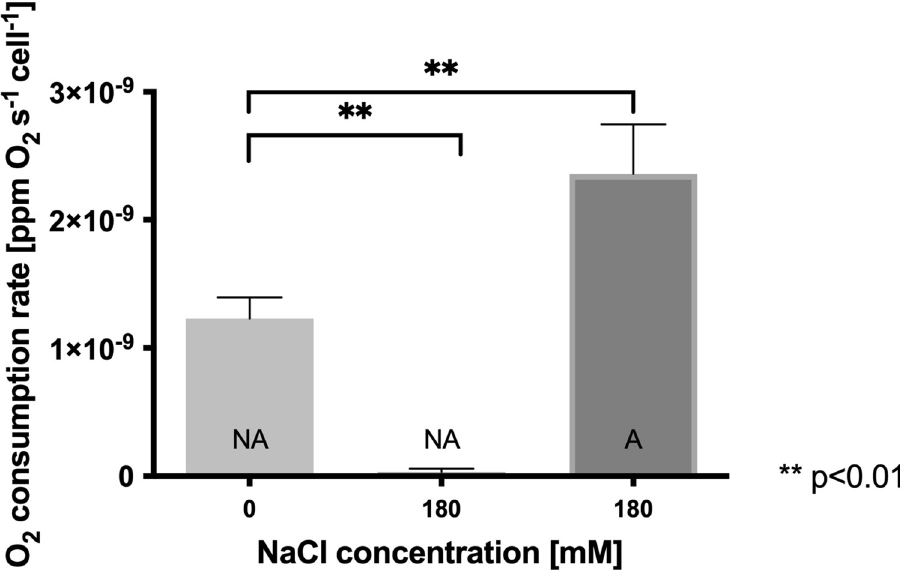
Fig 2. Effect of NaCl adaptation on oxygen consumption rate in L . ferriphilum DSM 14647. The measurements were carried out in adapted (A) cells exposed to 180 mM NaCl and non-adapted (NA) cells exposed to 0 or 180 mM NaCl. The data represent the average of 3 independent experiments. Error bars represent standard deviation. Statistical analysis was carried out by an ANOVA test.